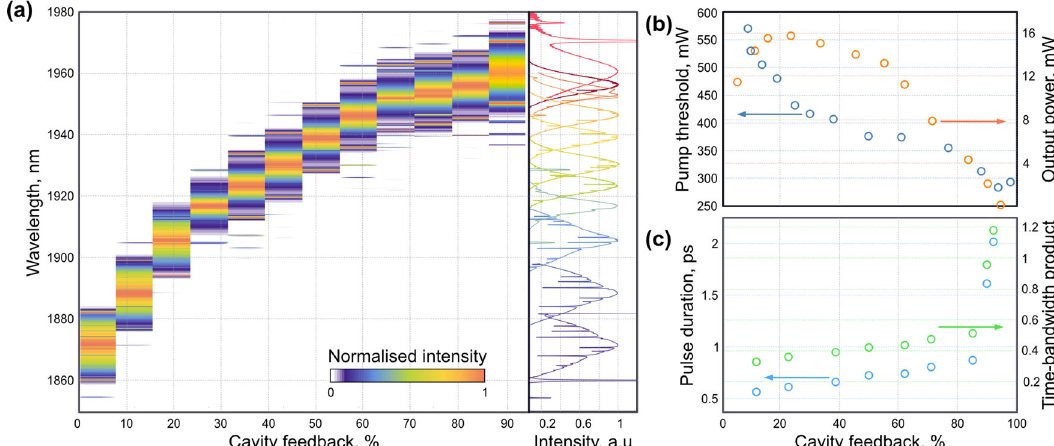
Fig. 5 Experimental study of feedback-controlled laser tuneability. Variation of output pulse characteristics with the variable coupler providing 8 to 93% feedback at fi xed polarisation state and 0.7 W pump power. a Wavelength tuneability of the optical spectrum; b variance of the pump threshold (blue, left axis) and output power (orange, right axis); c alteration of pulse duration (blue, left axis) and time-bandwidth product (green,